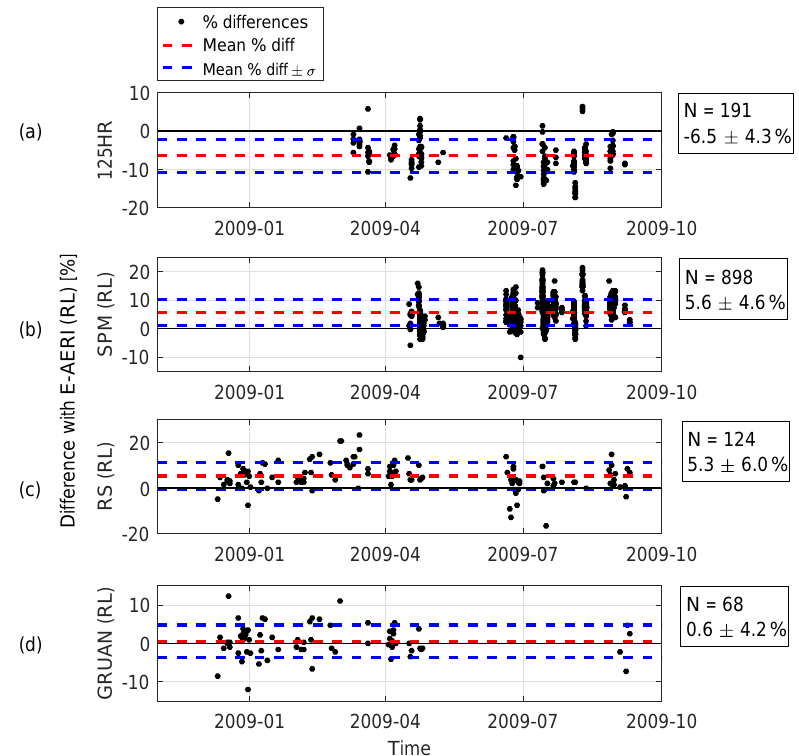
Figure 10. Same as Fig. 8 but for Ridge Lab-based comparisons between the E-AERI and the 125HR, SPM, RS, and GRUAN. Note that the RS and GRUAN datasets are columns calculated starting at the Ridge Lab altitude. (Percent differences calculated using Eq. 2 where X is E-AERI;